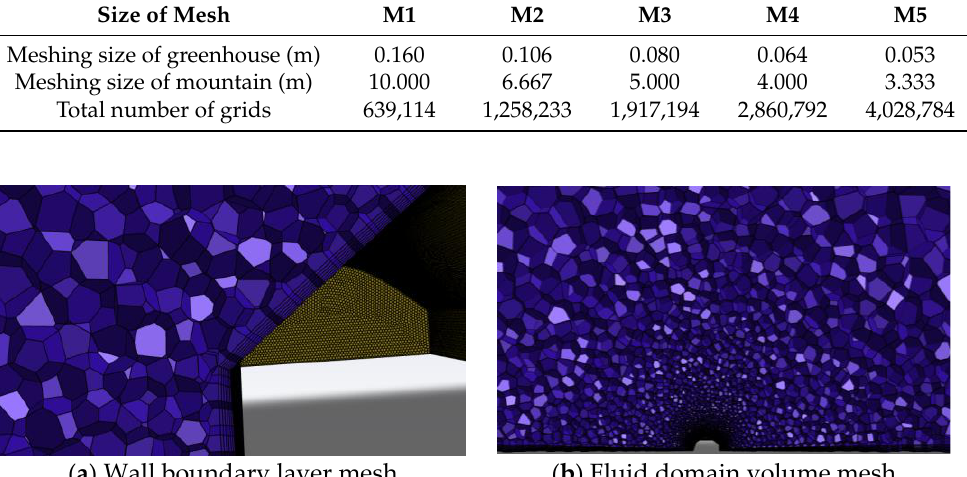
Figure 4. Layout of the model and size of the fluid domain size.